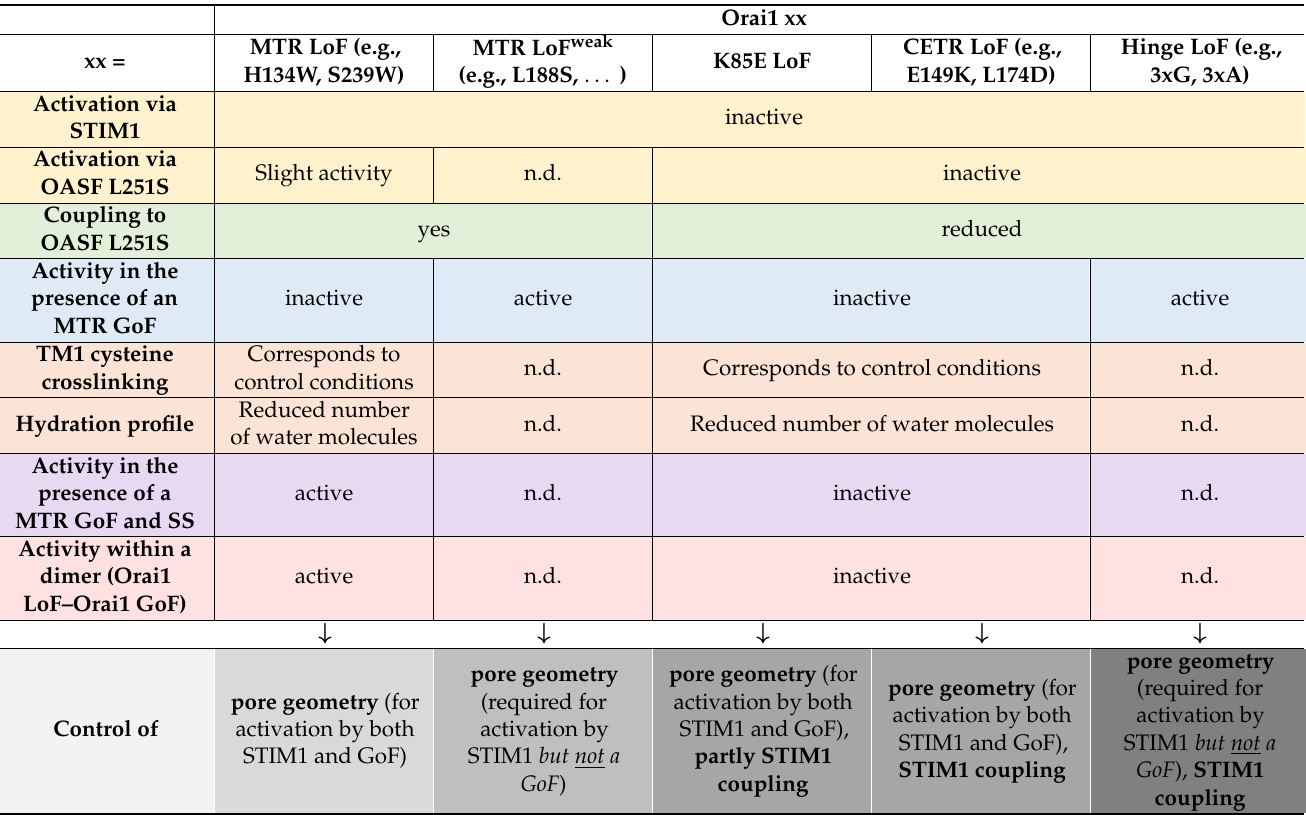
Table 3. Classification of MTR and CETR LoF mutants according to their effects on an opening-permissive pore geometry and/or STIM1